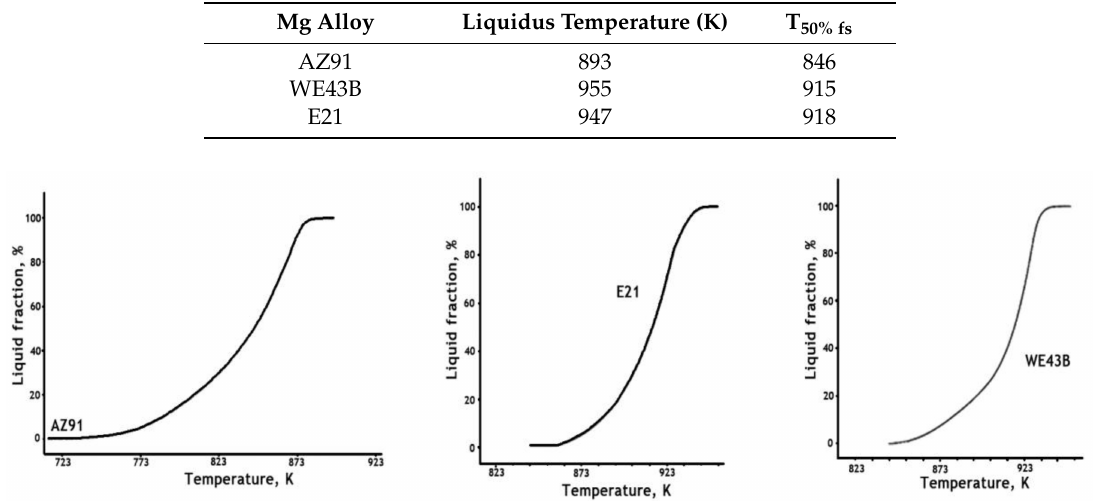
Table 2. The values of the liquidus temperature and the temperature of the solid phase content of 50% for the magnesium alloys analysed according to the DSC analysis.